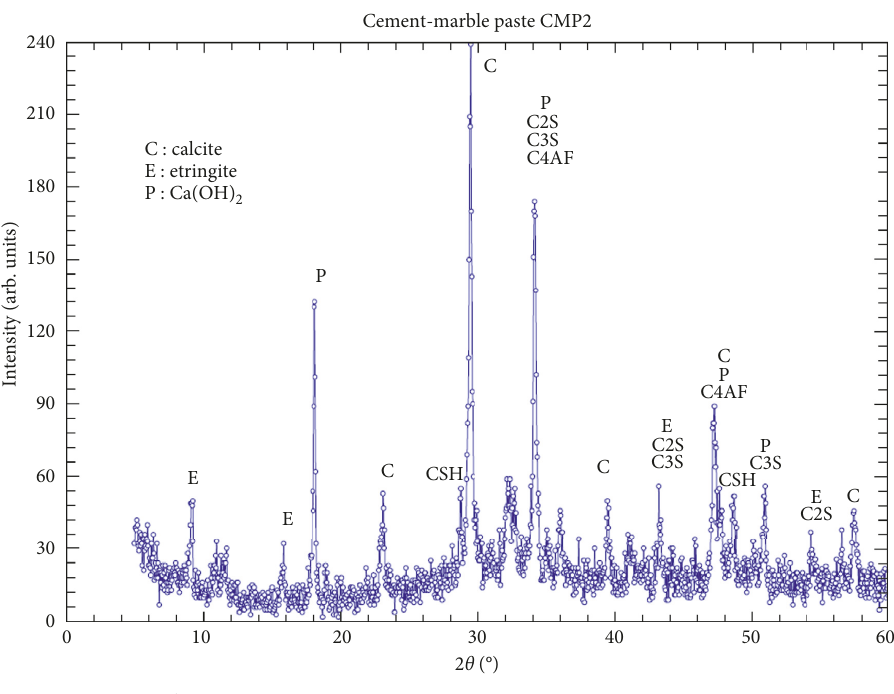
Figure 12: X-ray diffraction pattern of paste